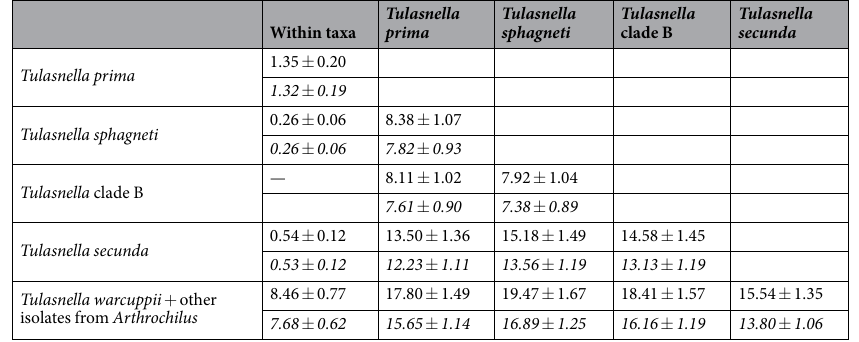
Table 1. Within host group and between host group Kimura − 2P and p-genetic (italicised) distances for Tulasnella as calculated from ITS.